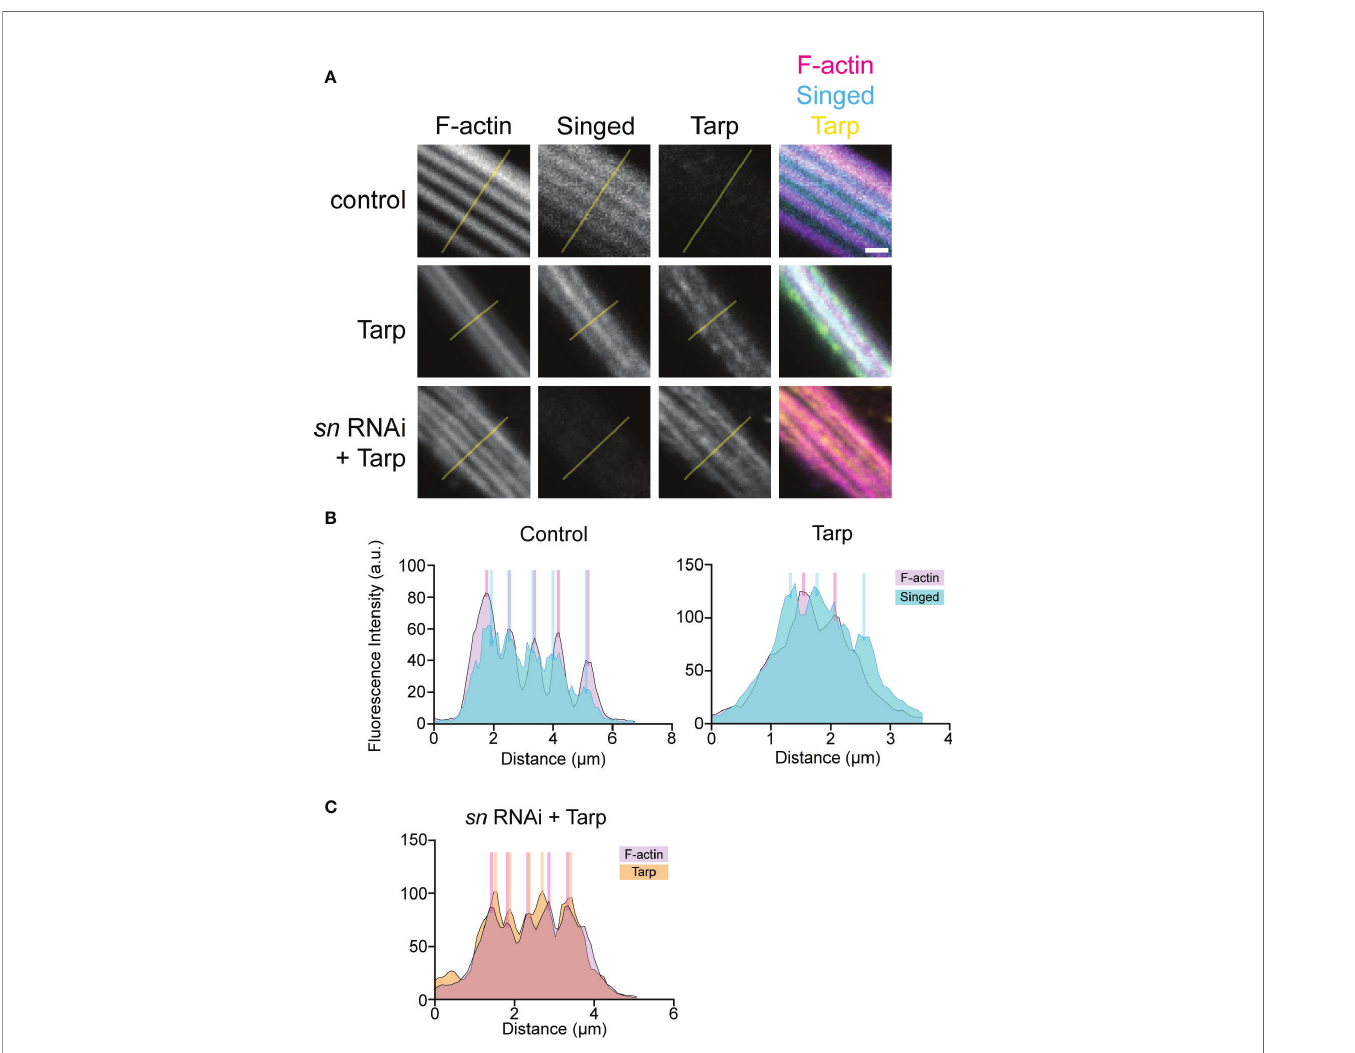
FIGURE 5 | Tarp expression results in mislocalization of host F-actin bundler Singed away from F-actin bundles in developing pupal bristles. (A) Line analysis of high-magni fi cation confocal micrographs of control and Tarp-expressing pupal bristles, as well as pupal bristle from fl ies that express Tarp in the singed RNAi background. Fluorescent pixel intensity along the length of the yellow line were plotted for each indicated channel (B, C) . Peak fl uorescent intensities, corresponding to the localization patterns, were highlighted with colored bars. Scale bar, 1 m m. Representative data and images are shown out of three